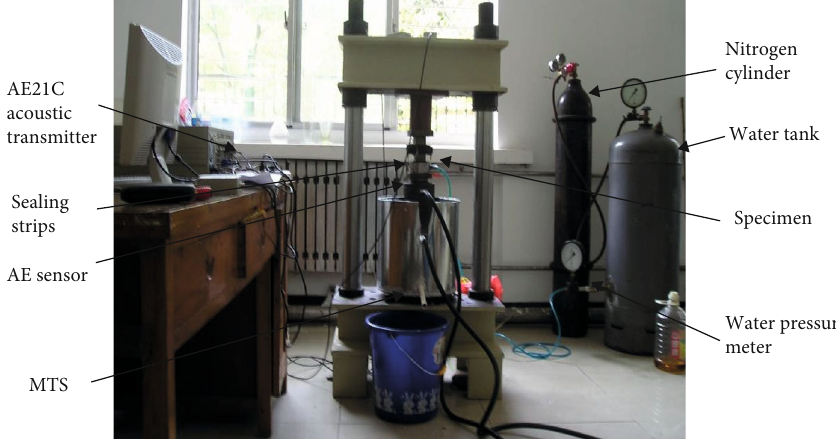
Figure 2: A photograph of the testing